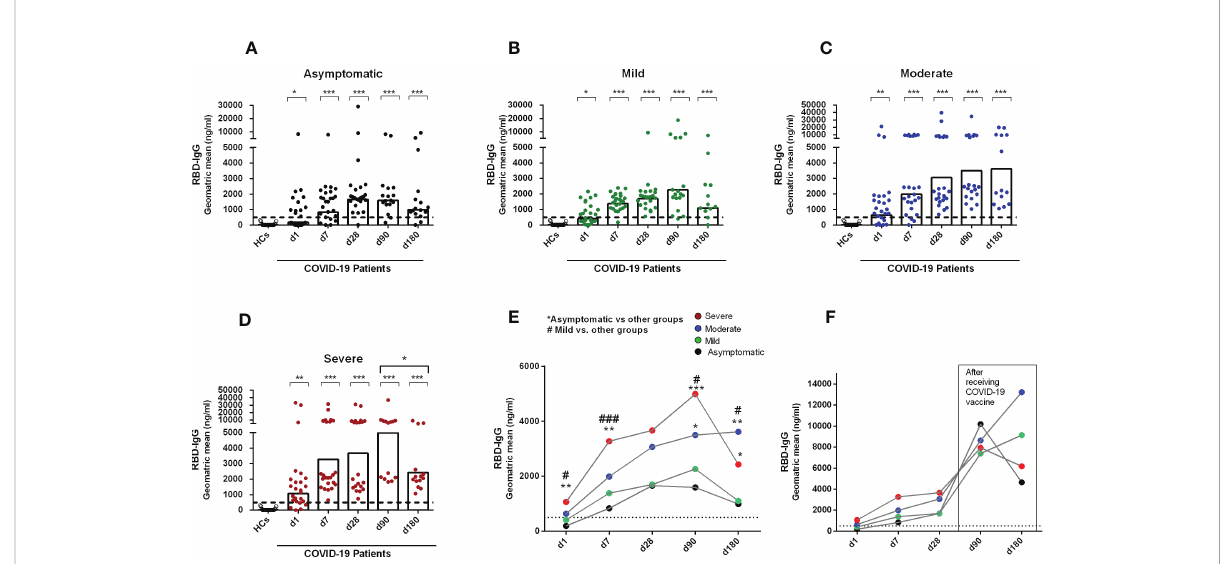
FIGURE 1 Antibody responses in COVID-19 patients with different disease severity, compared to healthy controls. RBD speci fi c IgG was analyzed in serum samples collected from healthy adults (n=21) as well as patients with (A) asymptomatic (n = 25), (B) mild (n = 25), (C) moderate (n = 25), and (D) severe (n = 25) COVID-19 on day 1, 7, 28, 90 and 180. Each symbol represents one individual, and bars indicate geometric mean values. Statistical analysis was performed between healthy controls and different time points in patients using the Mann-Whitney U test. Compared to healthy controls, all patients had signi fi cantly higher (P < 0.0001) IgG antibodies at all time points. (E) Line graphs showing the geometric mean values of antibody concentration in patients with differing disease severity. Statistical analysis was performed between asymptomatic vs. other groups (*) and mild vs. other groups (#) on each day using the Mann-Whitney U test. (F) line graphs showing the geometric mean values of antibody concentrations on day 90 (asymptomatic, n = 7; mild, n = 4; moderate, n = 4; severe, n = 6) and 180 (asymptomatic, n = 8; mild, n = 9; moderate, n = 10; severe, n = 6) in a patient group after receiving a COVID-19 vaccine one month after infection. Dotted line indicates the cut-off (500 ng/ml) limit of seropositivity. #/ * P < 0.05, ##/ ** P < 0.01, ###/ *** P < 0.001, ns, not signi fi cant; P >